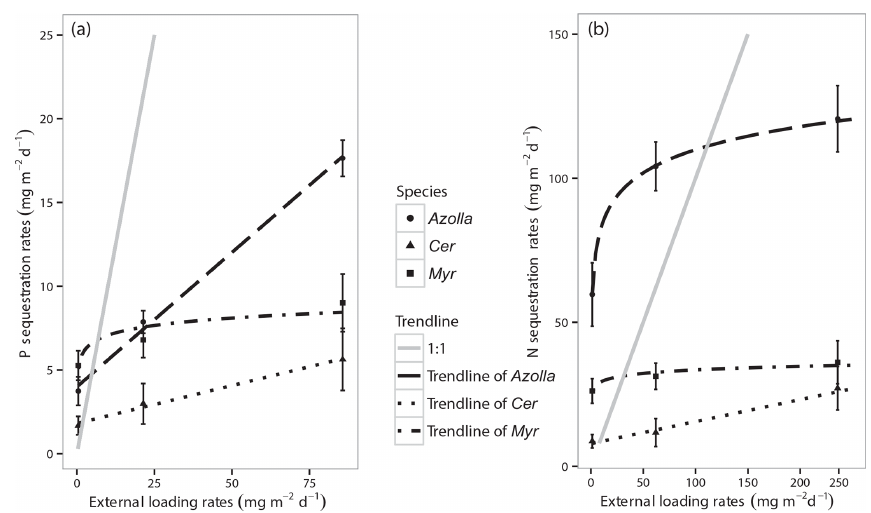
Figure 6. The correlations between external loading and nutrient sequestration rates of P (a) and N (b) by three different aquatic plant species. Standard errors and 1:1 line are given. Note that for A. filiculoides N 2 fixation is included in the sequestration rates, overestimating the effects of